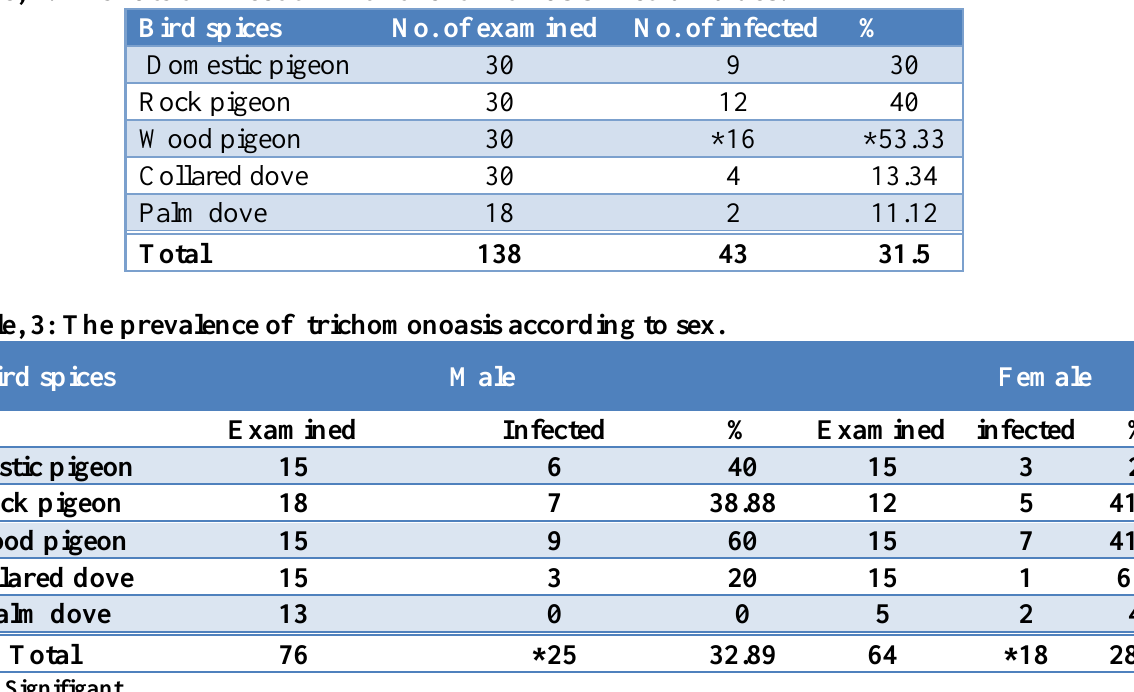
Table, 2: The rate of infection with trichoimoniasis in columbides.